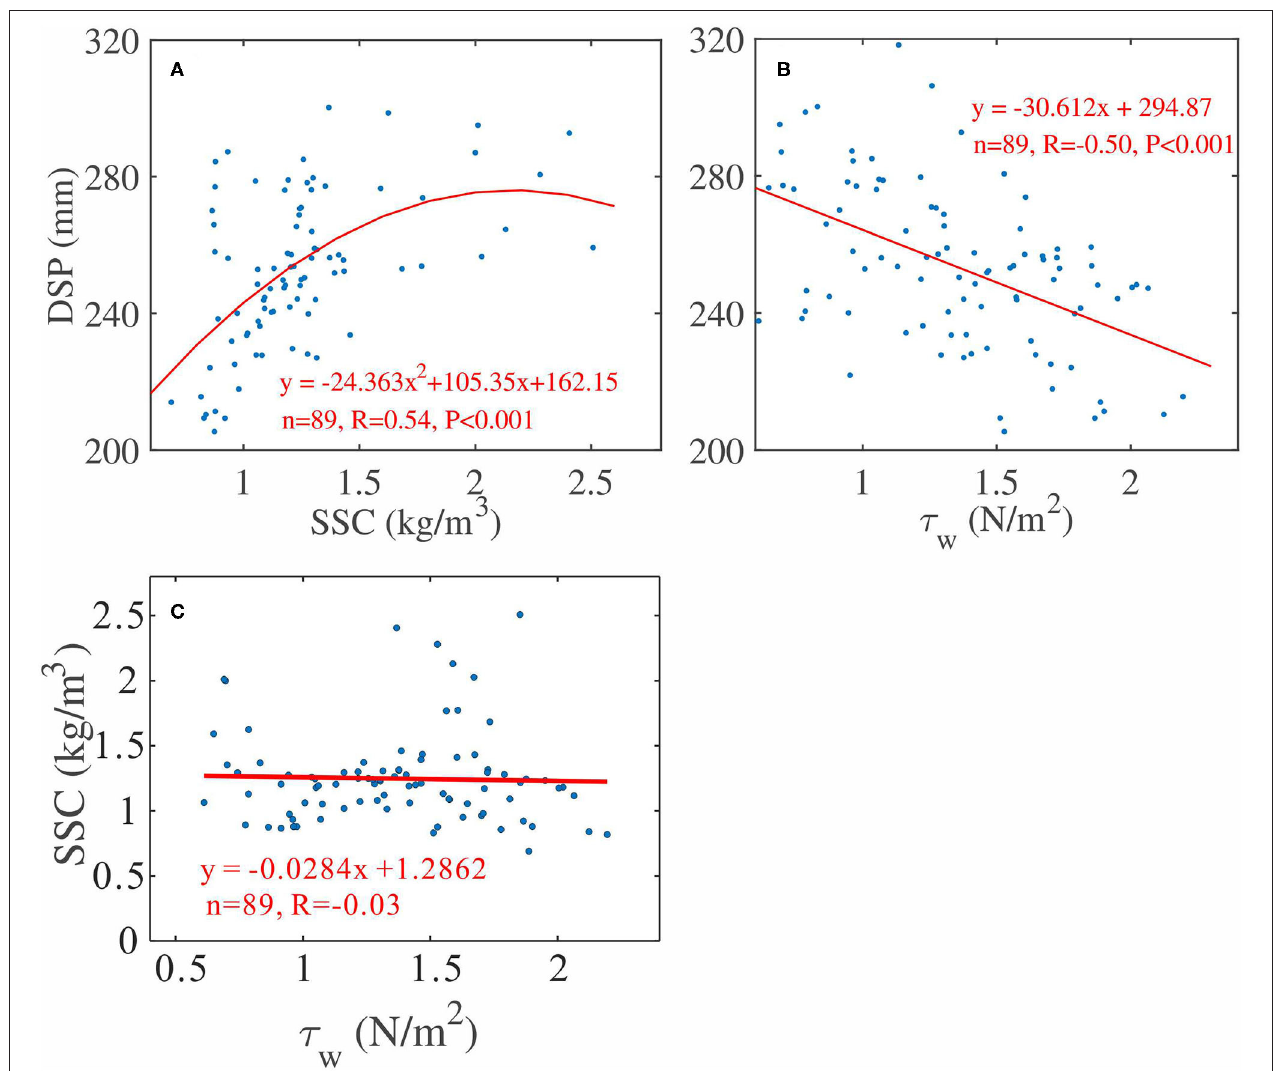
FIGURE 11 | (A) DSP against SSC; (B) DSP against bed shear stress induced by wave ( τ w ); (C) SSC against bed shear stress induced by wave ( τ w ) under moderate wave